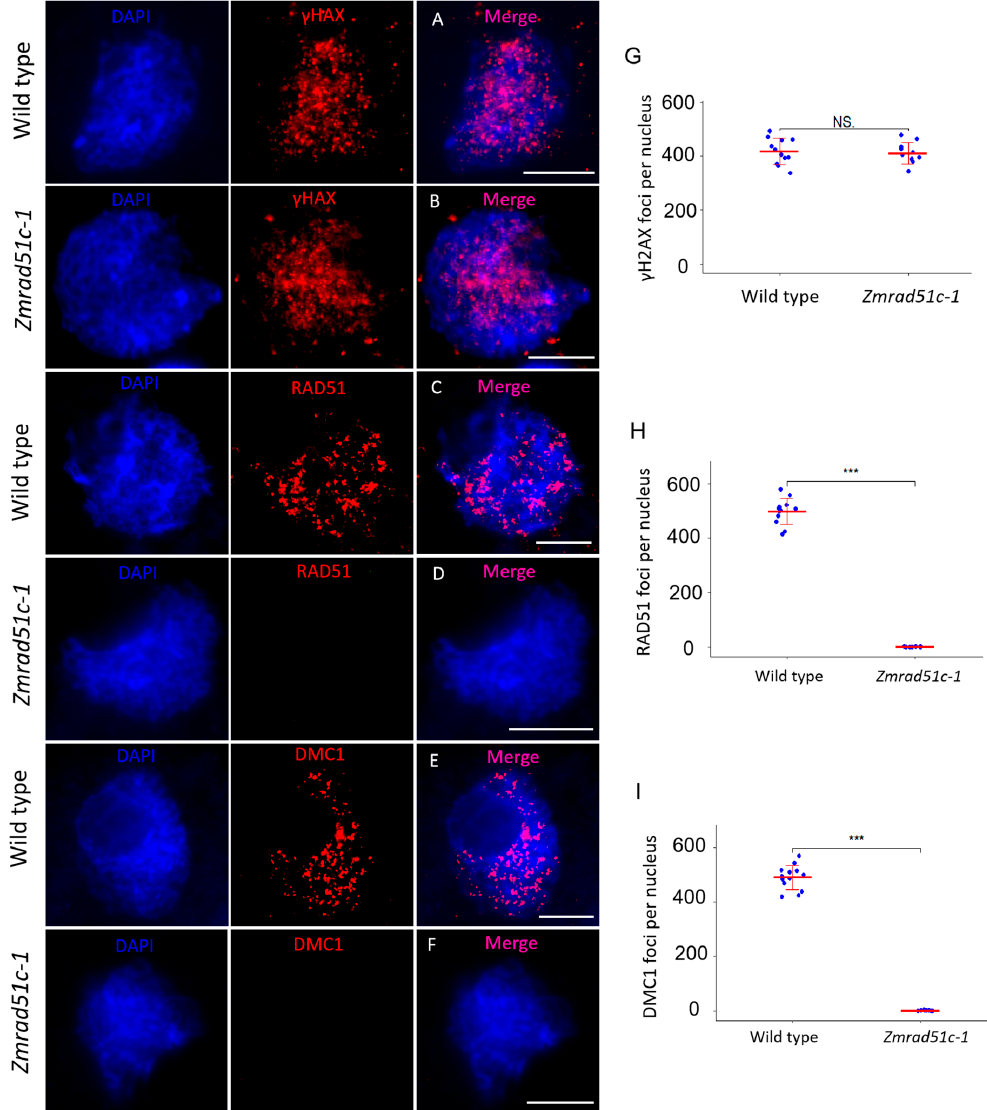
Figure 6. Immunolocalization of γ H2AX, RAD51 and DMC1 antibodies on meiotic chromosomes in wild type and Zmrad51c-1 meiocytes. ( A,B ) γ H2AX foci in wild type (A) and Zmrad51c-1 meiocytes (B). ( C,D ) RAD51 foci in wild type (C) and Zmrad51c-1 meiocytes (D). ( E,F ) DMC1 foci in wild type (E) and Zmrad51c-1 meiocytes (F). ( G – I ) Quantification and statistical analyses of γ H2AX, RAD51, and DMC1 foci between wild type and Zmrad51c-1 meiocytes. Triple asterisks indicate the statistical significant at p < 0.001 using a two-tailed Student’s t -test. NS means no significant di ff